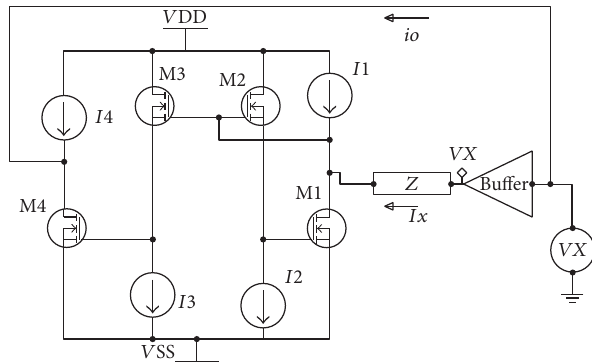
Figure 2: Circuit diagram of the proposed design.